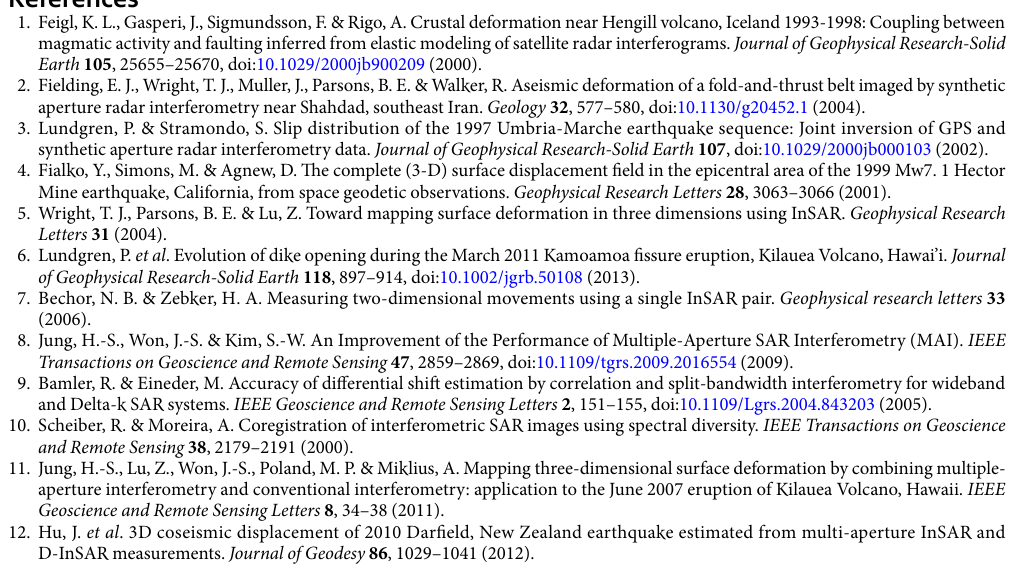
CMT (GCMT) reported an east-dipping fault plane from the moment tensor. However, the focal mechanism derived from the NCSS provided nodal planes characterizing an east-dipping fault with a strike/dip of 345°/85°. The strike of this fault plane is a little closer to the north-south direction than our modelled results, but dip angle is nearly the same. Thus, we confirmed that the focal mechanism solution was well-matched with the fault model derived from 3D modelling. Moreover, 3D modelling enabled us to obtain the high resolution focal depth of the earthquake compared to the seismic analysis. These results are within a reasonable range as defined by other satellite-based studies, but our analysis is unique due to the reconstruction of better-constrained 3D surface movements and the derivation of the fault’s optimal focal plane. These results support existing seismological interpretations and contribute to a better under- standing of the West Napa Fault’s behaviour.